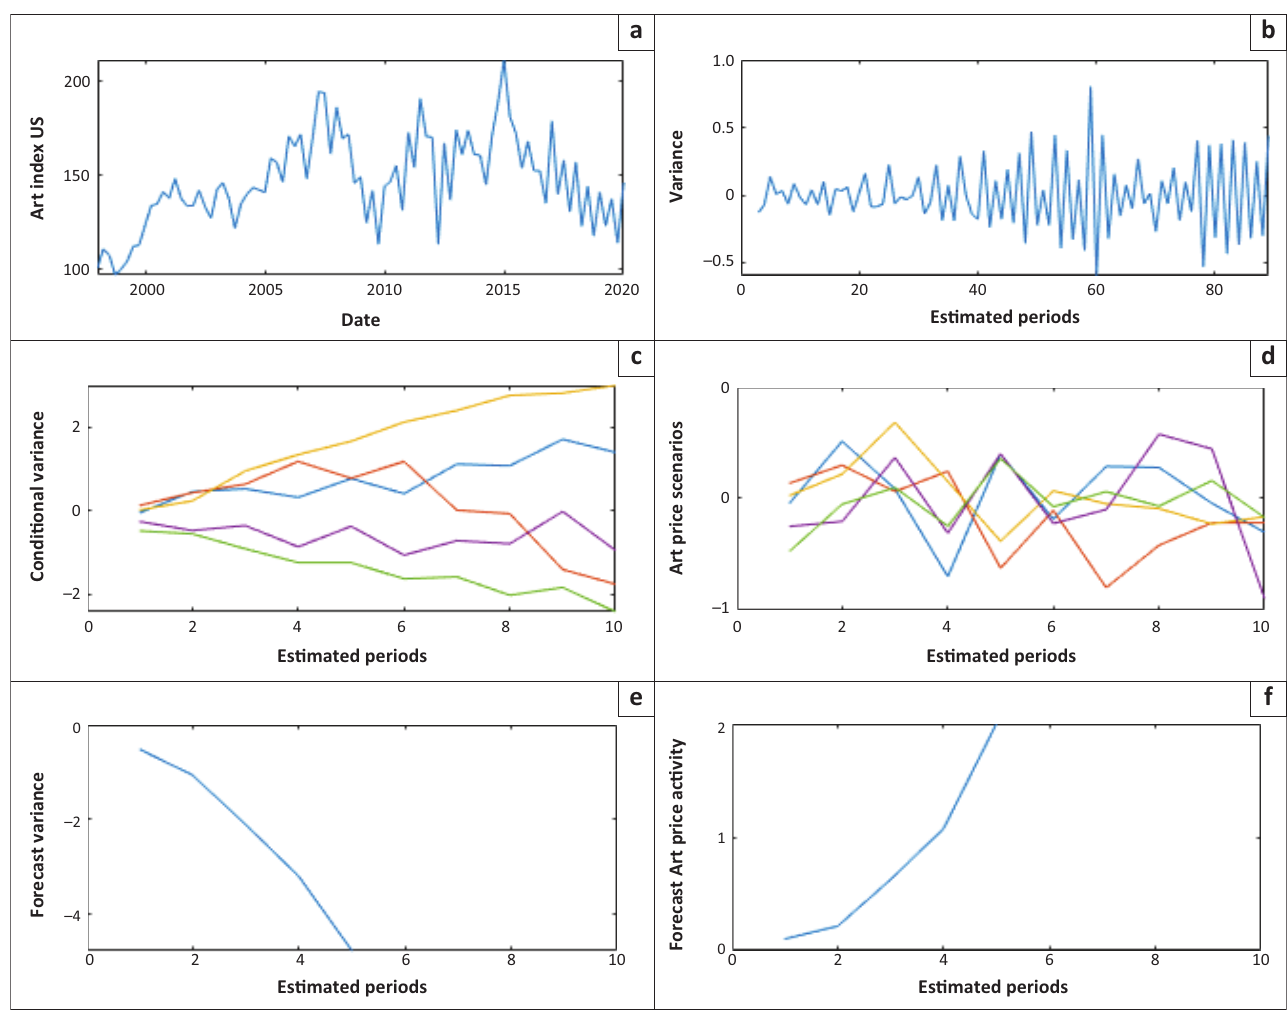
FIGURE 7b: European Euros using a 10-period estimation simulating 5 possible paths using quarterly data from 1998 to 2020. (a) Art price index EU, (b) Variance API EU, (c) Conditional variance 10 period esrimate, (d) 10 period simulation, (e) Conditional variance 5 period forecast, (f) 5 period